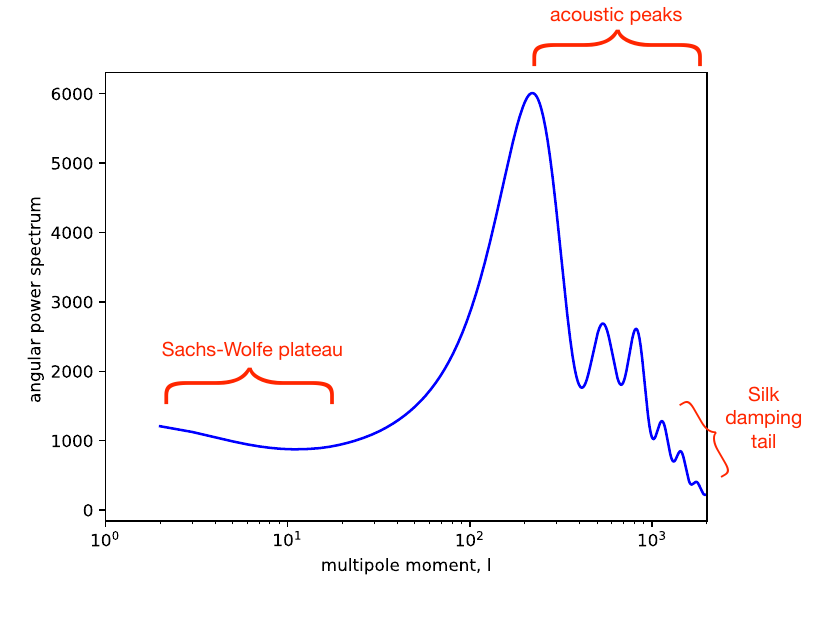
/ ( 2 π ) in ( µ K ) 2 , l ( l + 1 ) C l 0